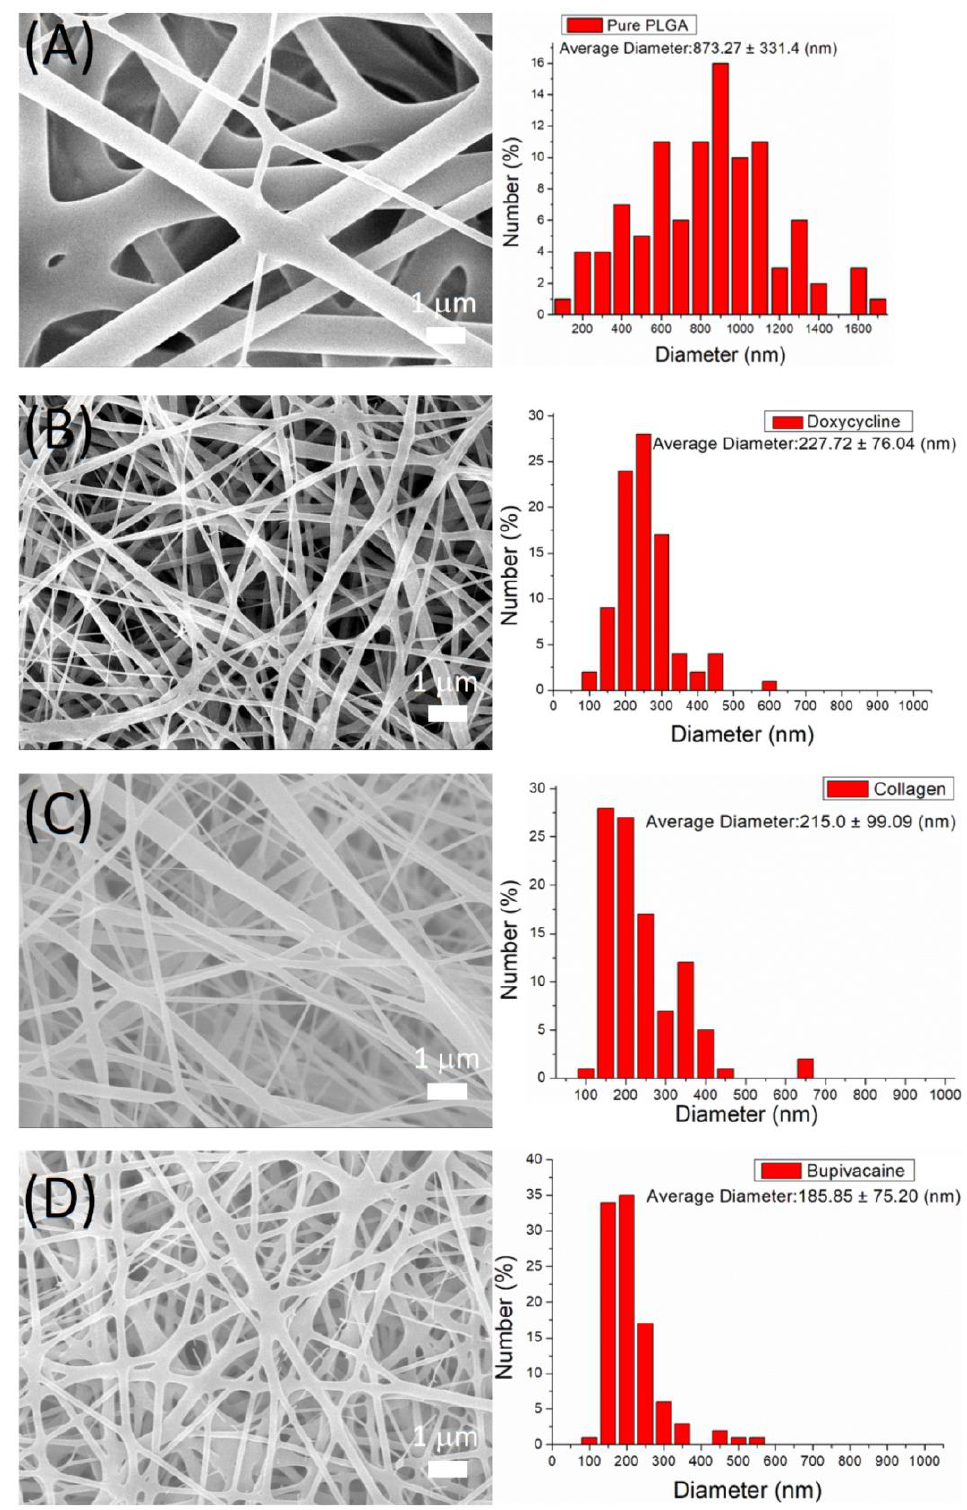
Figure 1. SEM image and size distribution of ( A ) pristine PLGA nanofibers, ( B ) doxycycline-loaded nanofibers, ( C ) collagen-loaded nanofibers, and ( D ) bupivacaine-loaded nanofibers. The water contact angles for the pristine and biomolecule-loaded PLGA nanofibrous mats were measured. Figure 2 shows that the contact angle of the pristine PLGA is 123.36 ◦